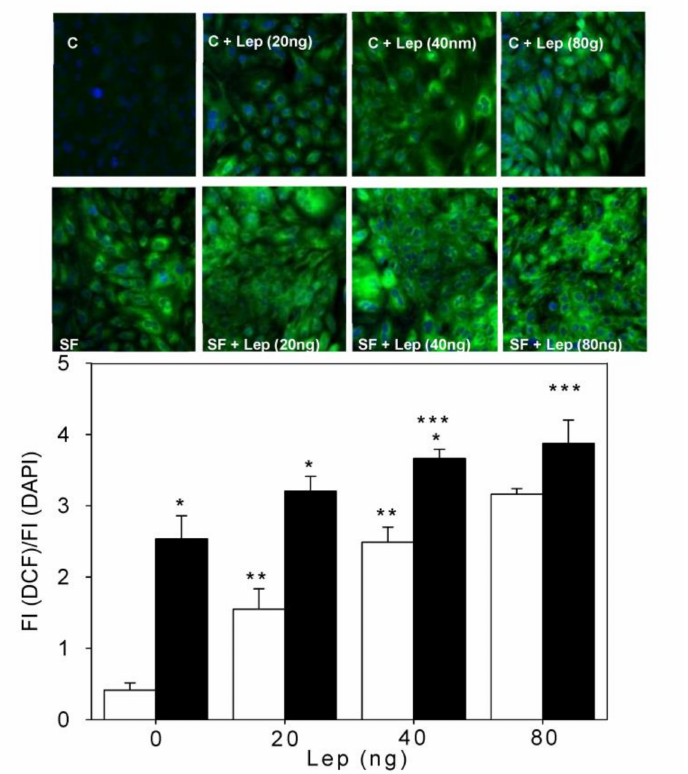
Figure 1. Leptin and ROS generation in SMCs. Aortic SMCs from both the control (C) and sucrose-fed (SF) rats were loaded with 10 µ M 2,7-dichlorodihydrofluorescein diacetate (DCF-DA) and treated with leptin at different concentrations (from a 20 to 80 ng/mL culture medium) followed by 5 µ M DAPI (Blue) to mark the nucleus, as described in the Method section. The FI of oxidized DCF (green) was detected using fluorescence microscopy equipped with a 20X objective (see images). All images were processed in the same conditions and using the same microscope parameter to determine fluorescence intensity. The graph presents the ratio of DCF FI to DAPI FI +/ − SD (n = 6 different experimental animals). The white bars correspond to the control SMCs and the black bars correspond to SF SMCs. * p < 0.01 corresponds to C vs. SF; ** p < 0.01corresponds to C vs. C + Lep and *** p < 0.05 corresponds to SF vs. SF +